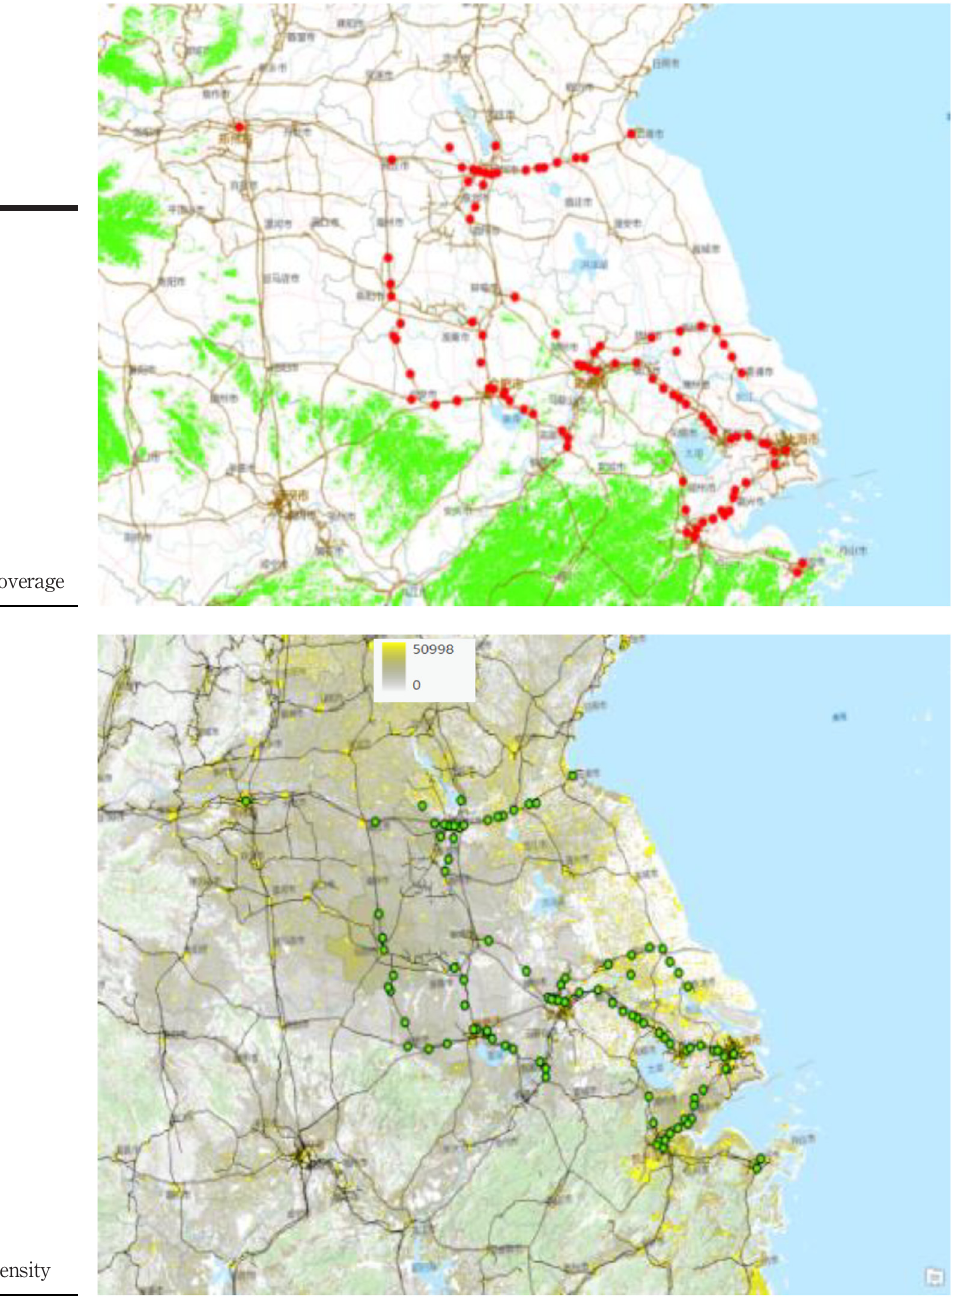
Figure 5. Population